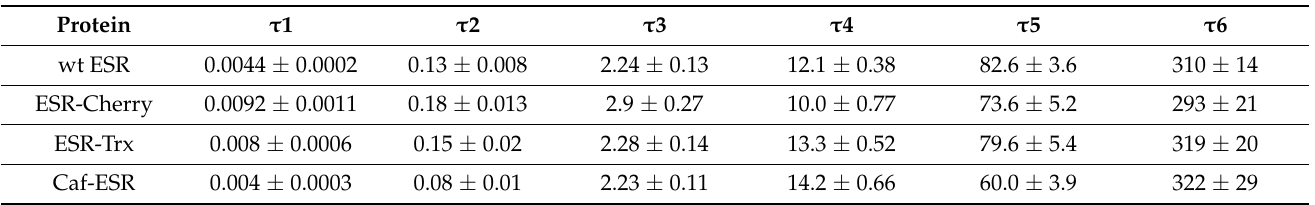
Table 2. Time constants (ms) of the photocycle in wild-type ESR and the hybrid proteins in DDM micelles at pH